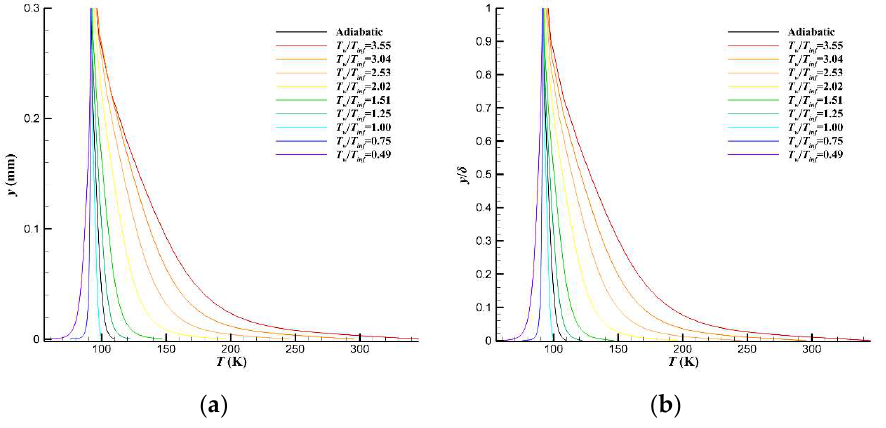
Figure 20. Temperature distributions of turbulent boundary layers. ( a ) T v.s. y ; ( b ) T v.s. y / δ.